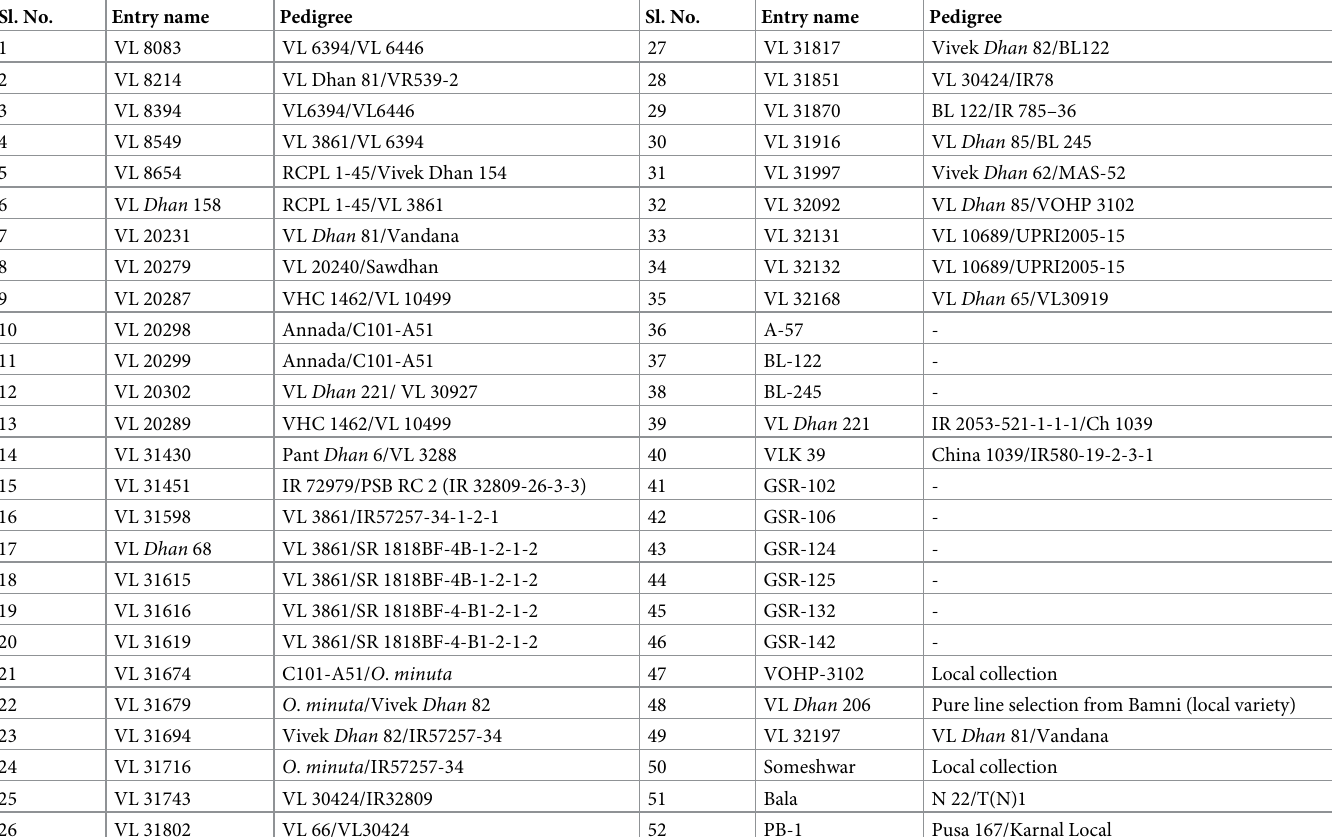
Table 2. List of rice genotypes along with their pedigree. Sl.